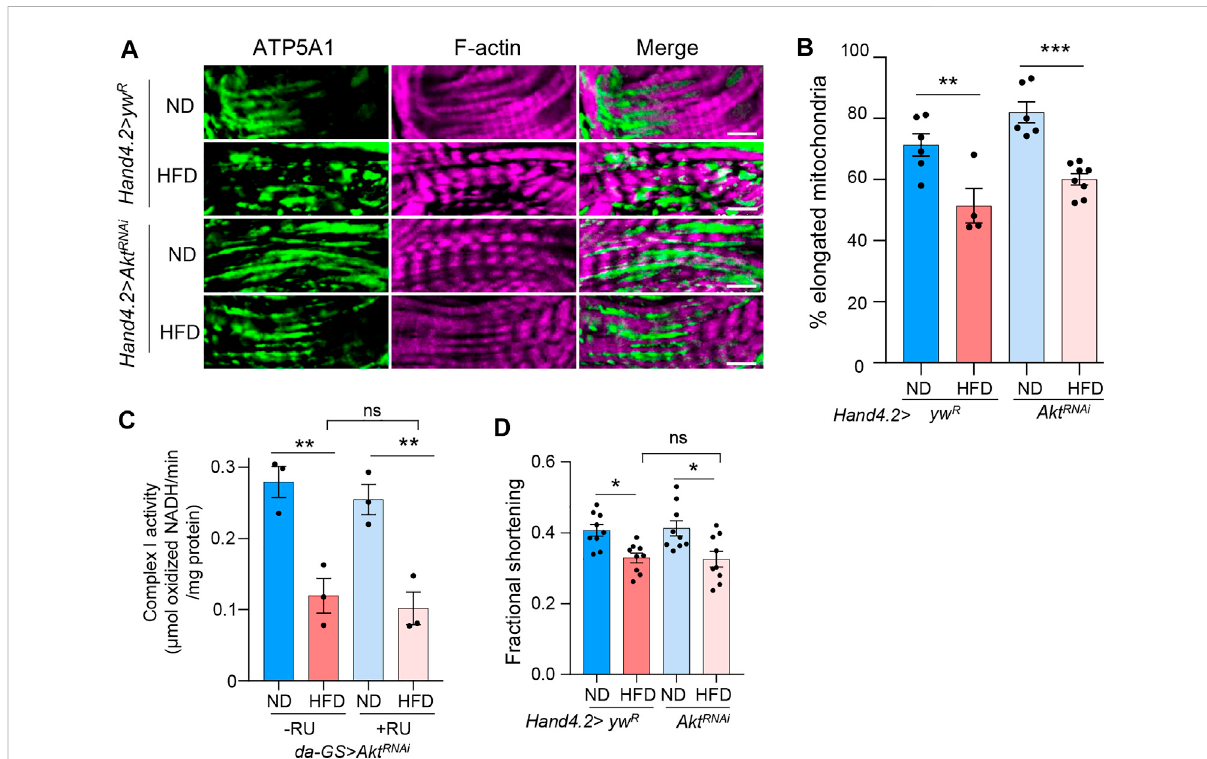
FIGURE 3 Akt is not responsible for mitochondrial fi ssion under HFD treatment. (A) Immunostaining of mitochondria and F-actin of cardiomyocytes from ND- or HFD-treated control and Akt knockdown fl ies. Mitochondria are visualized using an anti-ATP5A1 antibody. Scale bar: 10 μ m. (B) The proportion of the elongated mitochondria of the control and Akt knockdown fl ies under ND or HFD treatment. Two-way ANOVA: Interaction between diet and genotype is not signi fi cant, p = 0.7747. Tukey ’ s multiple comparison test: ** p < 0.01, *** p < 0.001. N = 6~8 (6~8 hearts per genotype). The control group re-uses the data from Figure 1F. (C) The complex I activity of the control and Akt knockdown fl ies under ND or HFD treatment.Two-wayANOVA:Interactionbetweendietandgenotypeisnotsigni fi cant, p =0.88.Tukey ’ smultiplecomparisontest:** p < 0.01,ns:not signi fi cant. N = 3(3 replicates, 20 fl iesper replicate). (D) The quanti fi cation of thefractional shortening of control and Akt knockdown fl ies. Two-way ANOVA: Interaction between diet and genotype is not signi fi cant, p = 0.2564. Tukey ’ s multiple comparison test: * p < 0.05, ns: not signi fi cant. N = 9~10 (9~10 fl ies per